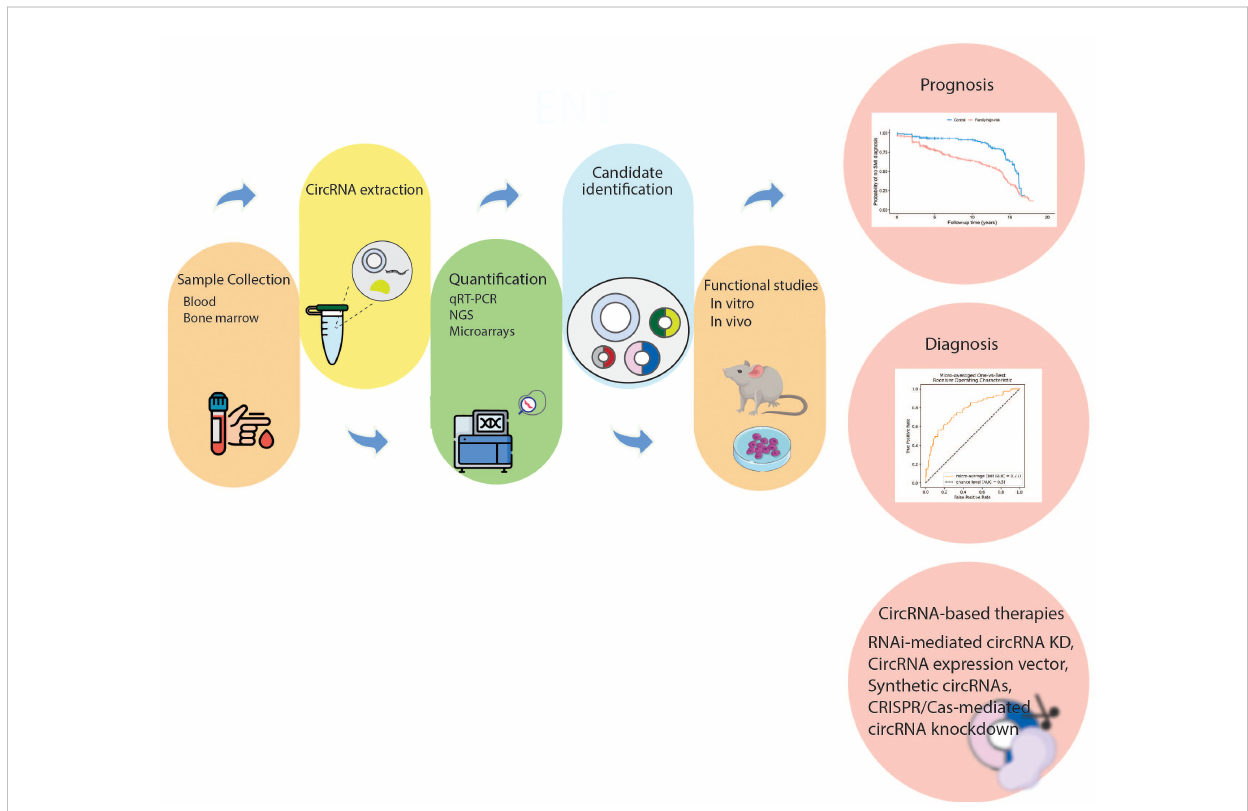
FIGURE 3 Clinical relevance of circRNAs in AML. The fi rst step is sample collection (bone marrow, serum, or plasma) to be used for circRNA detection. Subsequently, dysregulated circRNAs are quanti fi ed through molecular techniques. Then, the mechanisms of dysregulated circRNAs in AML pathogenesis are investigated in vivo and in vitro . The dysregulated circRNAs that can act as diagnostic or prognostic biomarkers are selected. Moreover, targeting speci fi c circRNAs may be an attractive treatment strategy. CircRNA, circular RNA; NGS, next generation sequencing; qRT-PCR, real-time quantitative polymerase chain reaction; RNAi, RNA interference; KD,